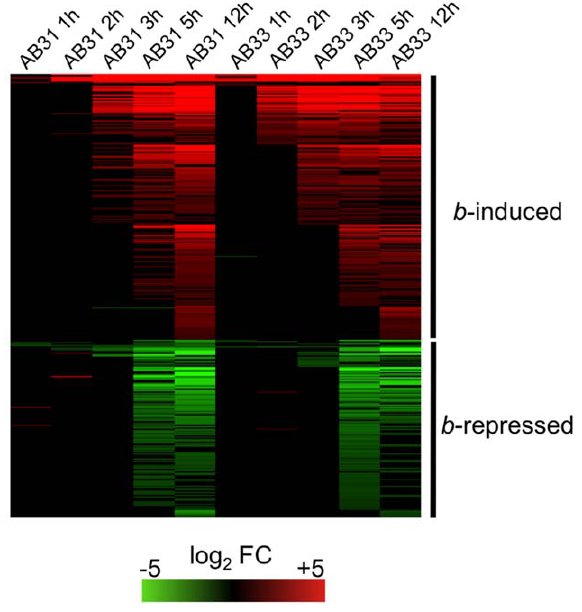
Figure 1. b -dependent gene expression. In U. maydis strains AB31 and AB33, expression of the bE1 and bW2 genes is controlled via the arabinose-inducible crg1 -promoter and the nitrate-inducible nar1 - promoter, respectively. Strains AB32 and AB34 are isogenic to AB31 and AB33, respectively, but harbor the incompatible bE2 and bW2 genes as control. bE/bW genes were induced by shifting the cells to array medium containing arabinose (AB31 and AB32) or nitrate (AB33 and AB34). Cells were harvested at the given time points, RNA was extracted and used for microarry-analysis (Affymetrix MPIUstilagoA gene chip). The heat-map indicates the significant changes (adjusted P , 0.01; change . 2) in gene expression for AB31 and AB33 at a given time point relative to the control strains AB32 and AB34. Order of genes from top to bottom and expression changes are given in Suppl. Table S1. Details for the statistics and filters applied are given in ‘‘Material and